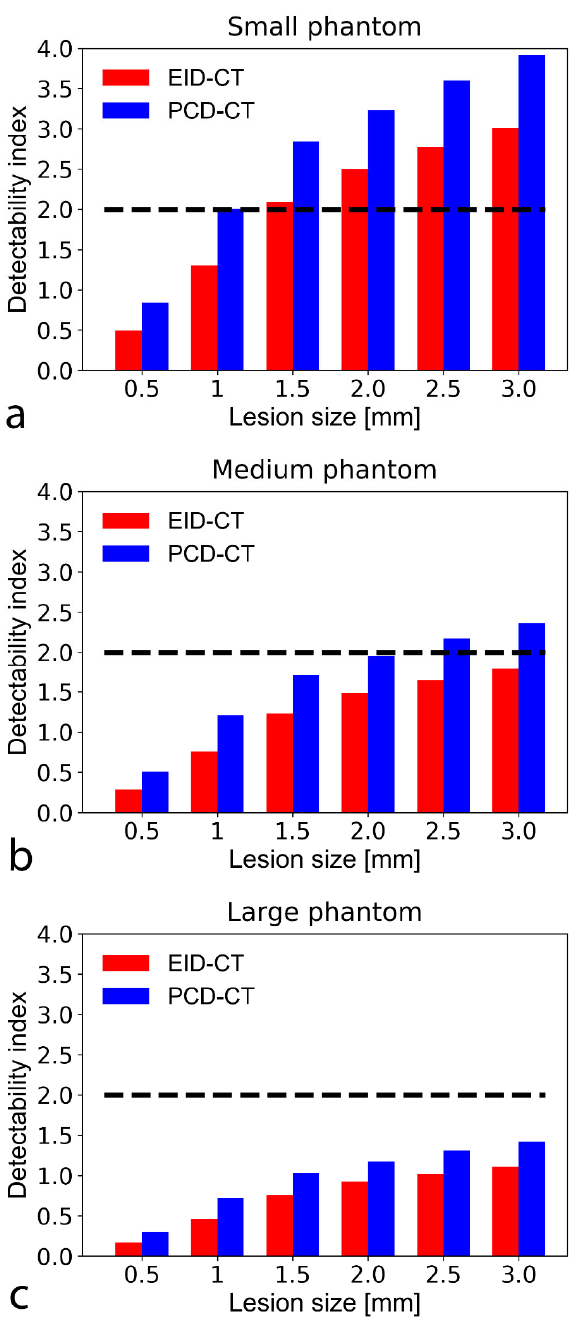
Figure 6. Bar chart shows detectability indices (d’) of lipid-rich atherosclerotic plaque with an object-to-background contrast | ∆ HU| of 30 HU in the small ( a ), medium ( b ), and large sized ( c ) phantom setup. A d’ of 2 corresponds to 90% accuracy (AUC), plotted on the graphs as a black dashed line. The PCD ‐ CT consistently provided higher detectability indices than the conventional system. At the tested CTDI of 10 mGy, neither the EID nor the SPCCT reached 90% AUC to detect a 0.5 mm lipid core. With the small phantom, the EID and SPCCT systems reached 90% AUC down to a lipid core size of 1.5 and 1 mm, respectively. AUC—area under the curve; CTDI—computed tomography dose index; EID ‐ CT—energy ‐ integrating detector computed tomography; PCD ‐ CT—photon ‐ counting detector computed tomography.